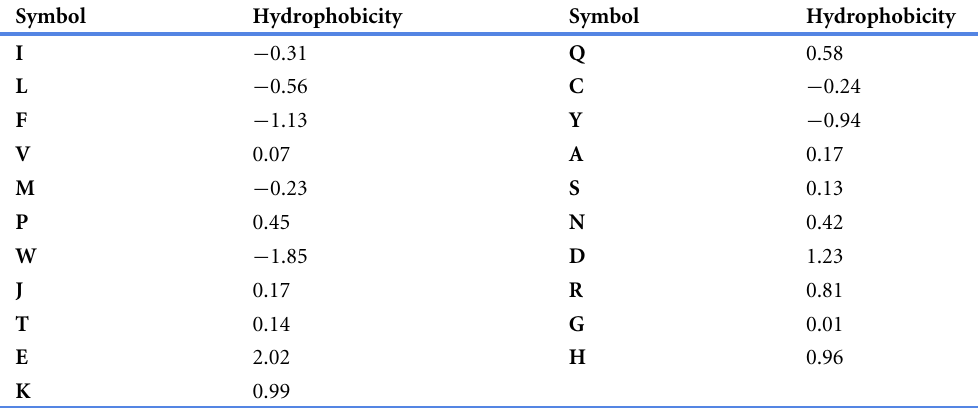
Table 1 Table of amino acids and their respective hydrophobicity values ( Rose et al., 1985 ).